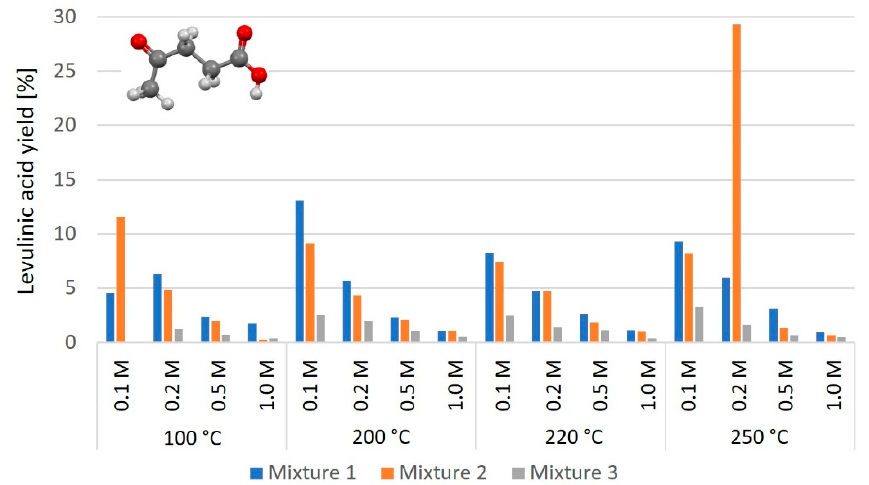
Figure 6. Levulinic acid yield as a function of catalyst concentration, temperature, and mixtures of hemicellulosic raw material—5 h process.